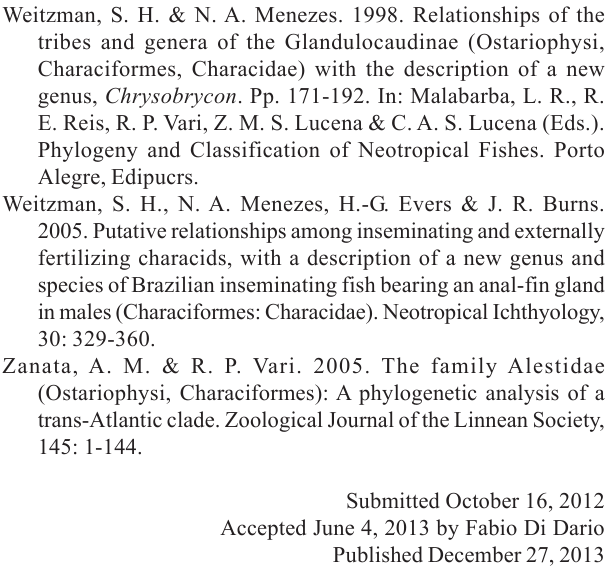
Supplementary File 2: List of characters in phylogenetic analyses. Supplementary File 3: Data